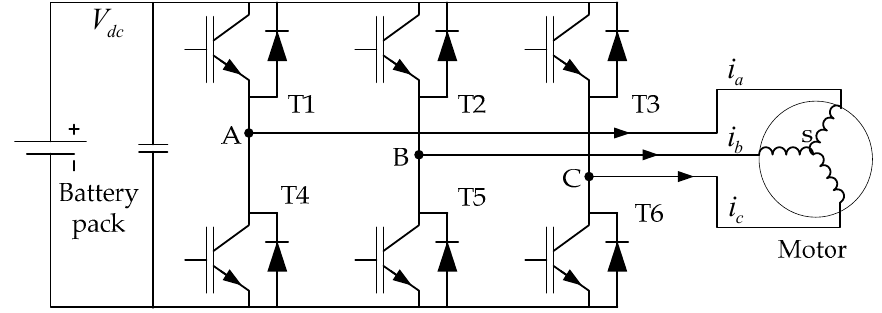
Figure 1. Structure of the three-phase inverter.